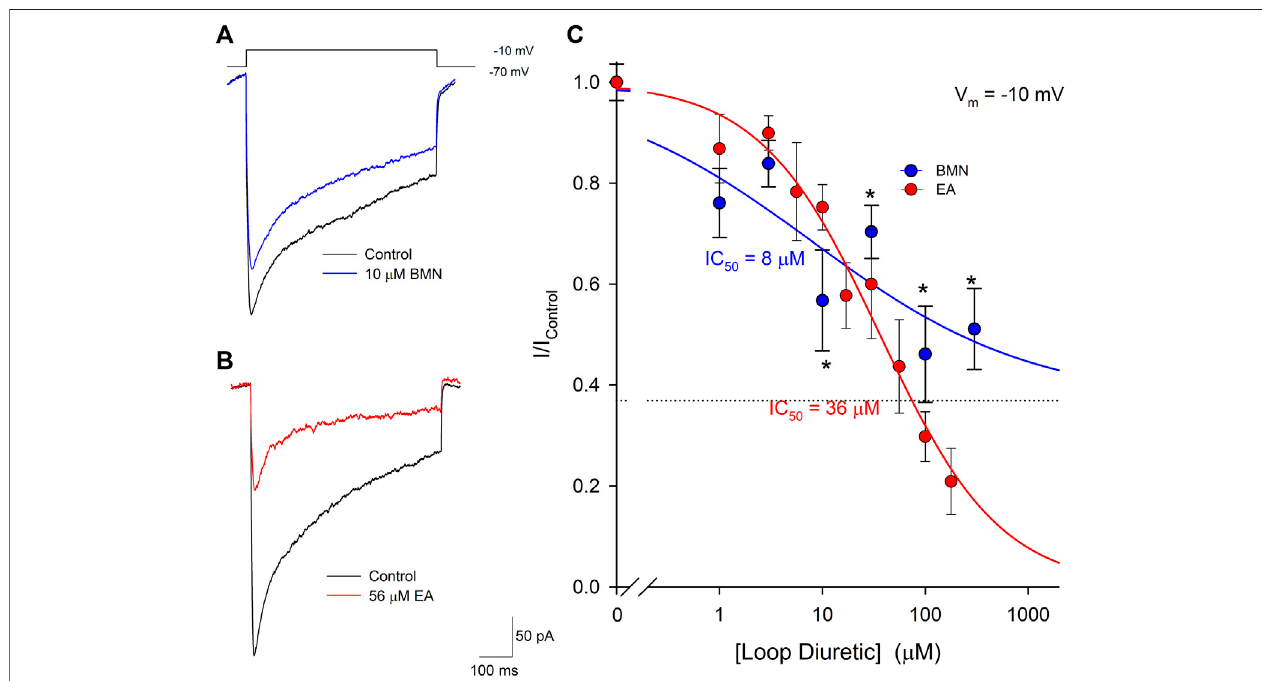
FIGURE 5 | Bumetanide and ethacrynic acid inhibit voltage-gated calcium channels in a dose-dependent manner. (A) , Representative traces of whole-cell VGCC currentsrecordedfromasingleneuroninresponsetoa500 msecstepfromaholdingpotentialof − 70 mVto − 10 mVintheabsence(Control,blacktrace)andpresence of 10 μ M bumetanide (10 μ M BMN, blue trace). (B) , Representative traces of whole-cell VGCC currents recorded from a single neuron in response to a 500 msec step from a holding potential of -70 mV to − 10 mV in the absence (Control, black trace) and presence of 56 μ M ethacrynic acid (56 μ M EA, red trace). (C) , Concentration-response relationships of relative peak inward VGCC currents (mean ± SEM) activated by voltage steps from − 70 mV to − 10 mV. Currents were normalized to control peak currents measured in the absence of bumetanide or ethacrynic acid. Data points (bumetanide blue circles; ethacrynic acid red circles) were best fi t (bumetanide blue line, ethacrynic acid red line) using a single-site Langmuir-Hill equation with an asymptotic minimum (dashed line for BMN). n > 7 for each data point. Asterisks denote signi fi cant difference from Control ( p <